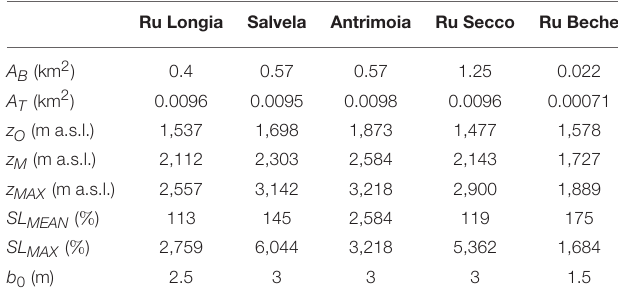
TABLE 2 | Morphometric characteristics of the basins: A B , basin area; A T , threshold area for channel network; z O , basin outlet altitude; z M , mean basin altitude; z MAX , maximum basin altitude; SL MEAN , mean slope; SL MAX , maximum slope; b 0 , outlet